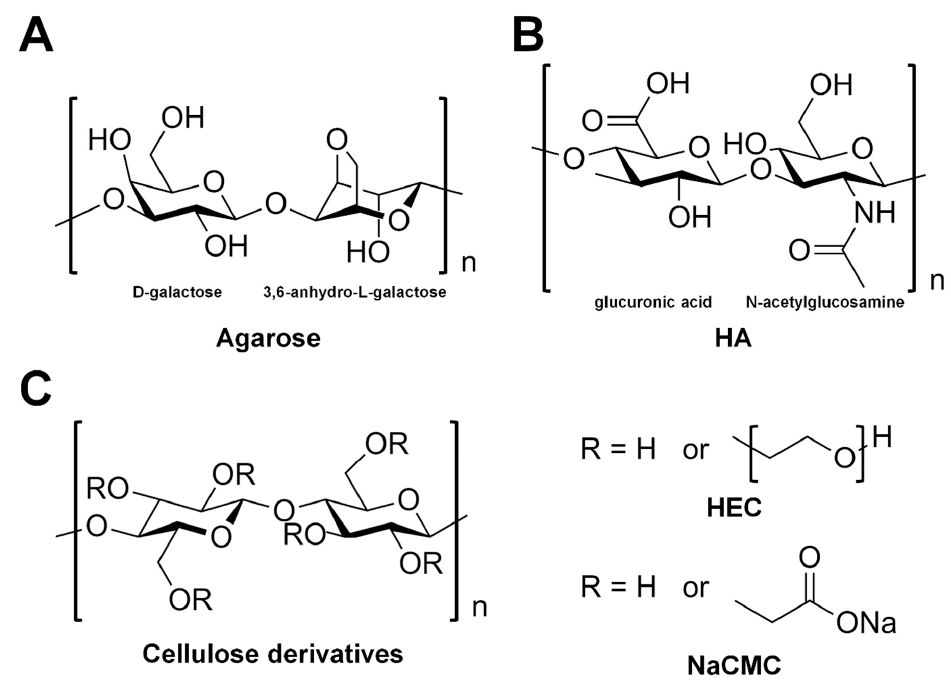
Figure 6. Chemical structure of polysaccharide-based hydrogels. ( A ) Agarose, composed of β -(1-4)-(3,6)-anhydro- L -galactose (left) and α -(1-3)- D -galactose (right). ( B ) Hyaluronic acid (HA) composed of alternating residues of β - D -(1-3) glucuronic acid (left) and β - D -(1-4)- N -acetylglucosamine (right). ( C ) Structure of cellulose derivatives. In hydroxyethyl cellulose (HEC), R is H or hydroxy ethyl group (–CH 2 CH 2 –OH). In carboxymethyl cellulose sodium salt (NaCMC), R is H or carboxymethyl groups (–CH 2 –COOH).